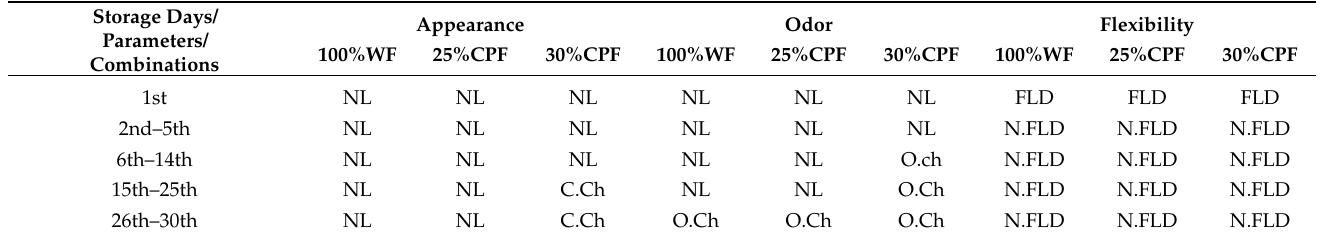
Table 7. Appearance, odor, and flexibility variations of durum wheat tortilla and fortified durum wheat tortillas during storage. CPF: chickpea flour. Values are mean ± SD ( n =